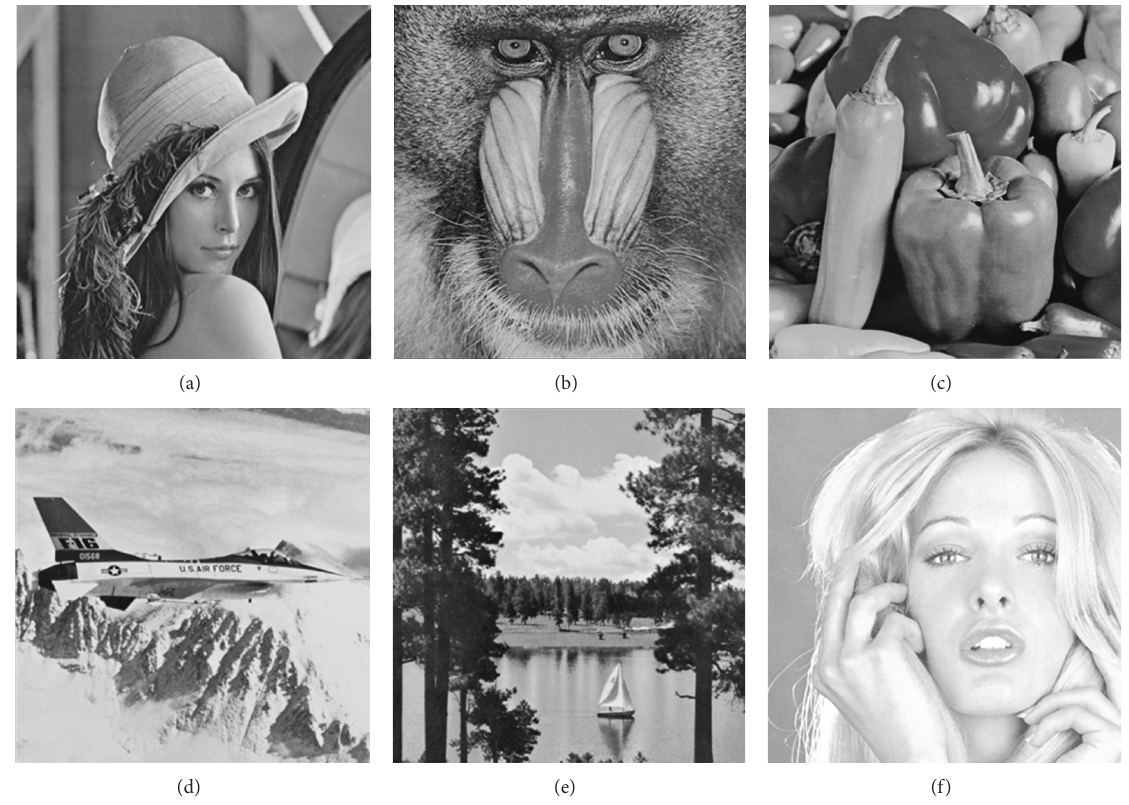
Figure 4: Six test images: (a) Lena, (b) Baboon, (c) Peppers, (d) Jet, (e) SailBoat, and (f) Tiffany.